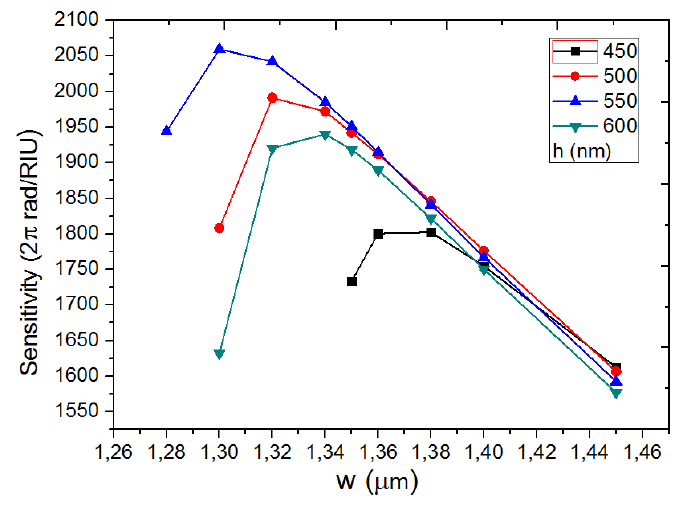
Figure 2. The relationship between sensitivity and waveguide width, w under different waveguide height, h .